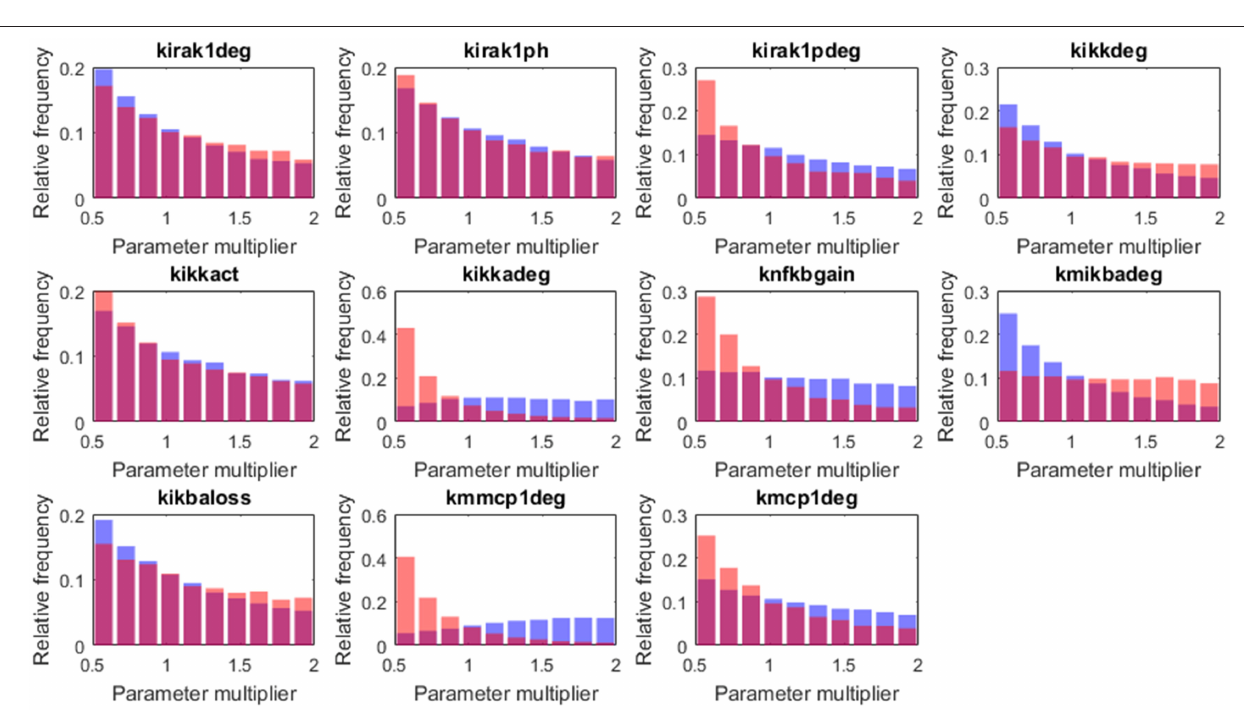
but it relies on high proliferation and low dwelling probability. Finally, subpopulation 4 is characterized by low values of dwelling probability and low